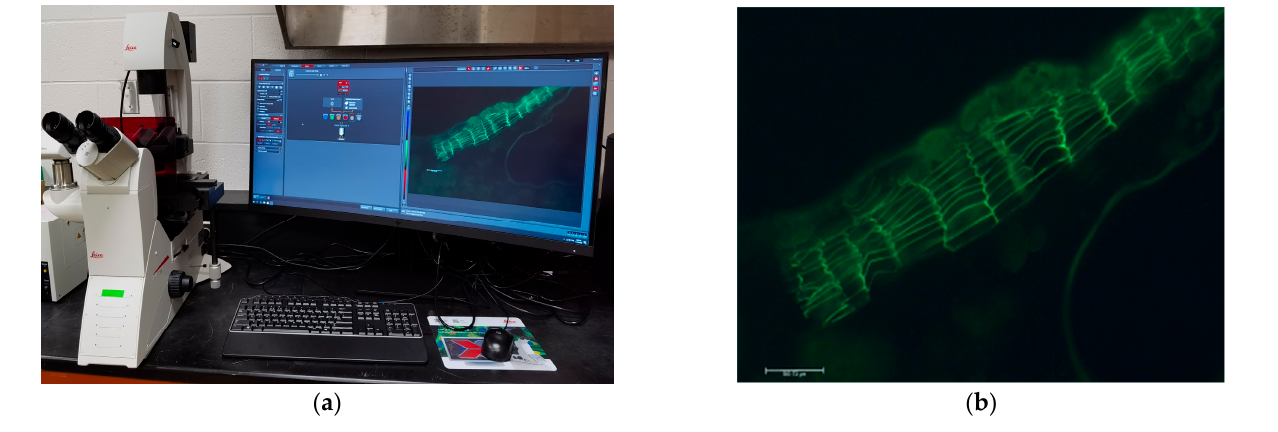
Figure 10. Analysis of the suberized cell layer. ( a ) The Lecia microscope (Leica DMi8) and Leica external light source for fluorescence excitation (Leica EL6000) and camera system (Leica DMC6200); ( b ) Image of the suberized cell layers under the fluorescence (captured by Leica LAS X Imaging and Analysis Software), showing the number of layers of suberized cells. (Leica system can be found in Leica Microsystems Inc., 71 Four Valley Drive, Concord, Ontario, L4K 4V8, Canada.)